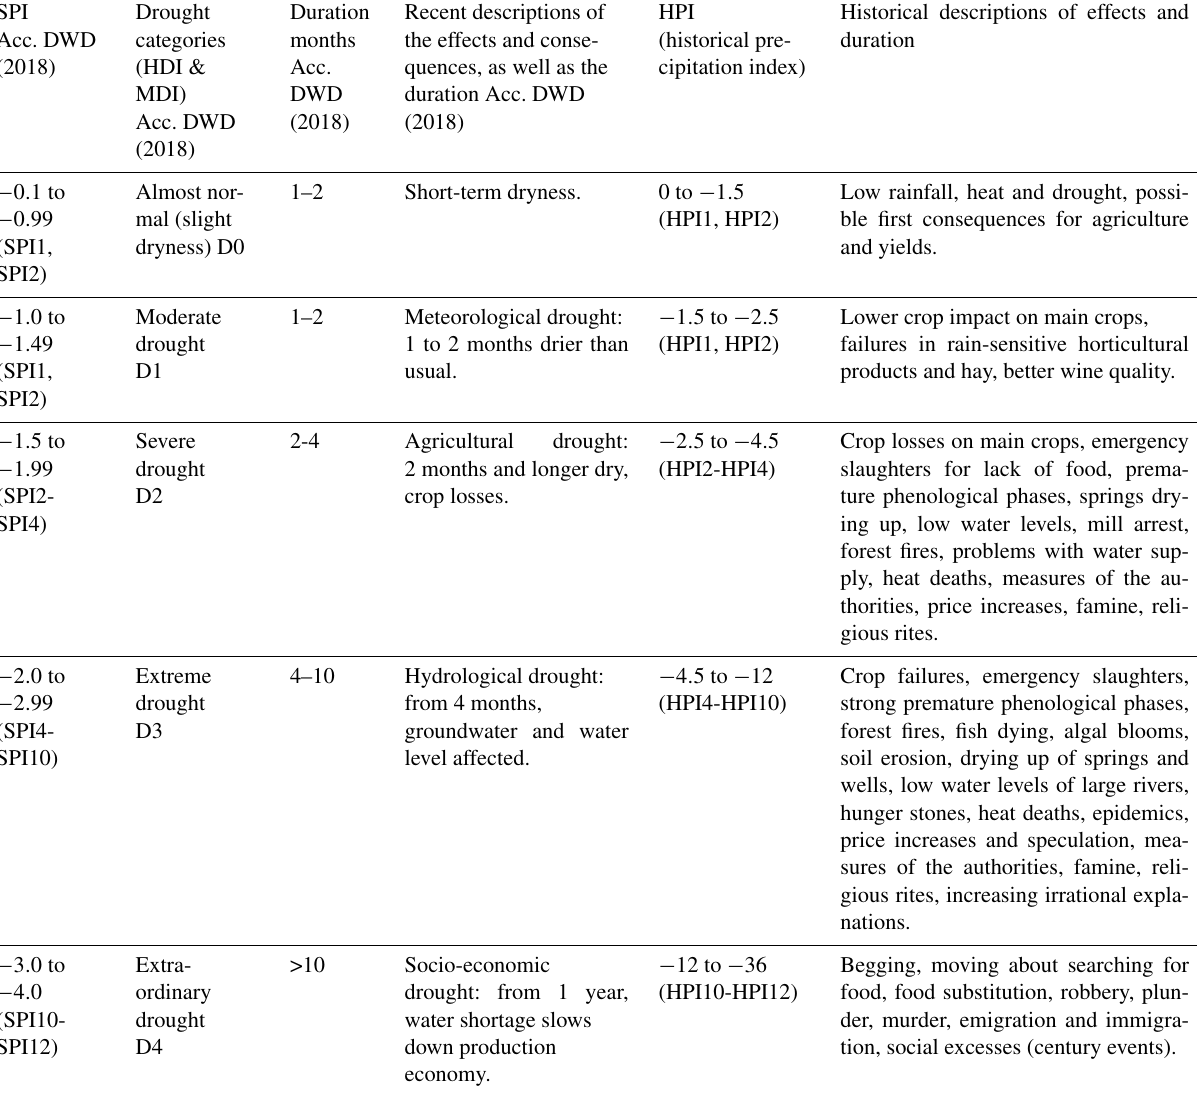
Table 3. Synopsis of SPI and HPI and numerical and hermeneutic drought categories. SPI Acc.